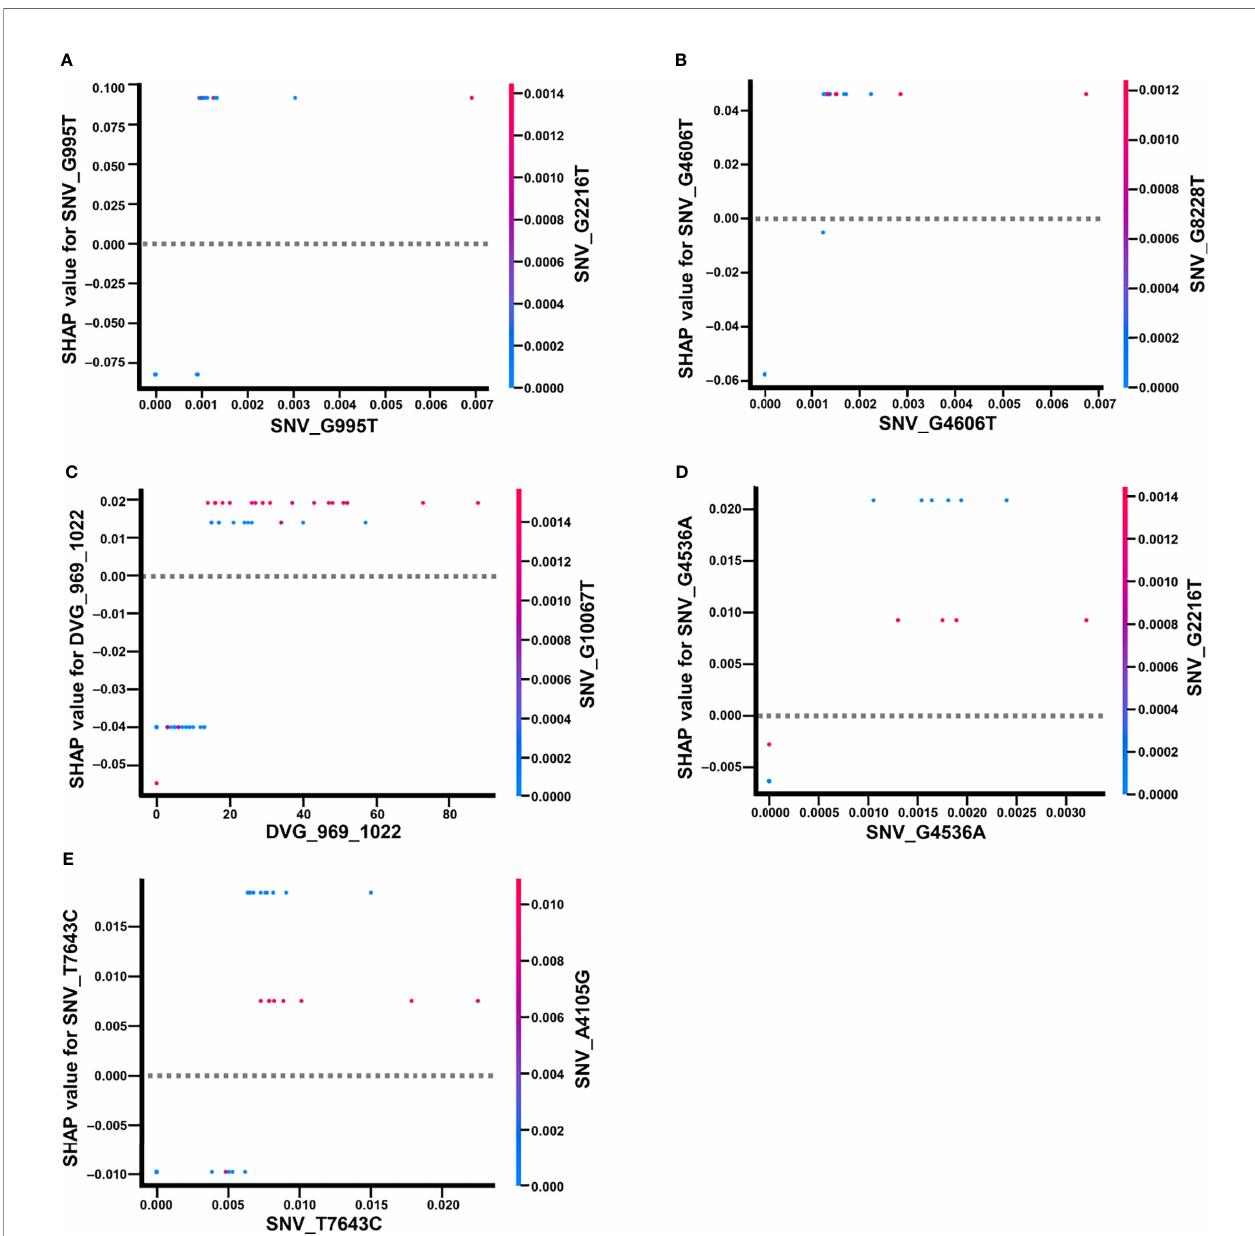
FIGURE 8 | Dependence plots of the ML model using SHAP explainer. Dependence plots of the ML model showed the potential cooperative effects of feature pairs on prognosis outcomes. For each feature, its most associated feature was chosen to be analyzed using dependence plots. The feature pairs were (A) SNV_G995T and SNV_G2216T, (B) SNV_G4606T and SNV_G8228T, (C) DVG_969_1022 and SNV_G10067T, (D) SNV_G4536A and SNV_G2216T, and (E) SNV_T7643C and